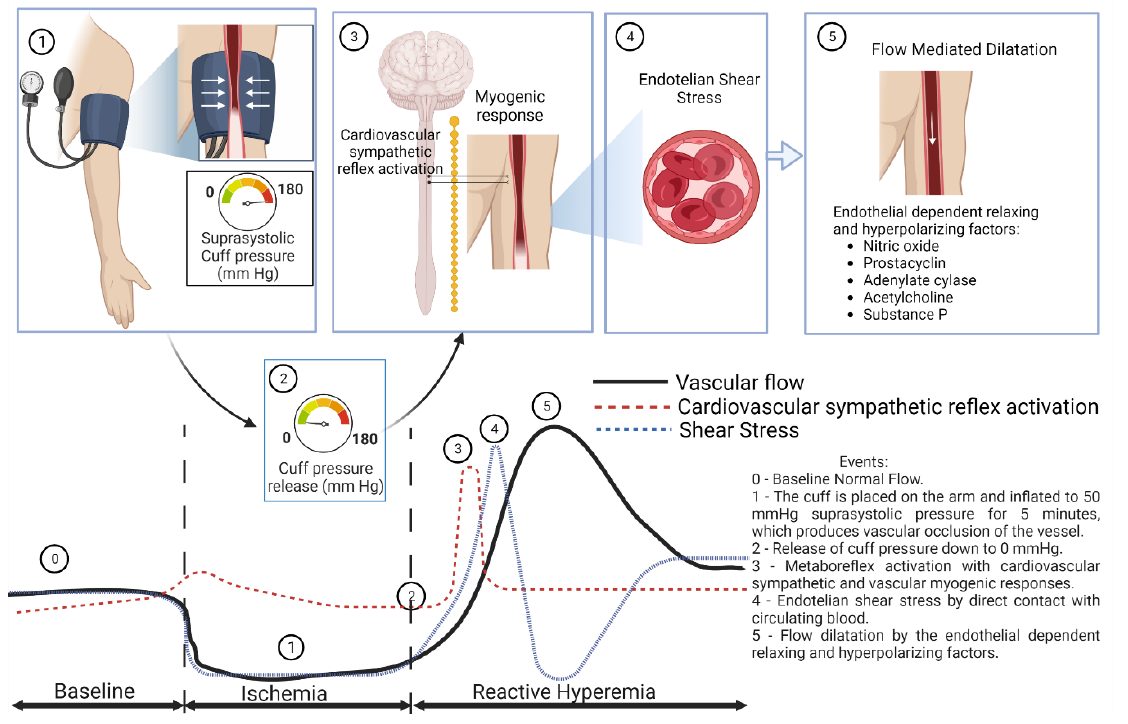
Figure 5. Schematic diagram about reactive hyperemia.